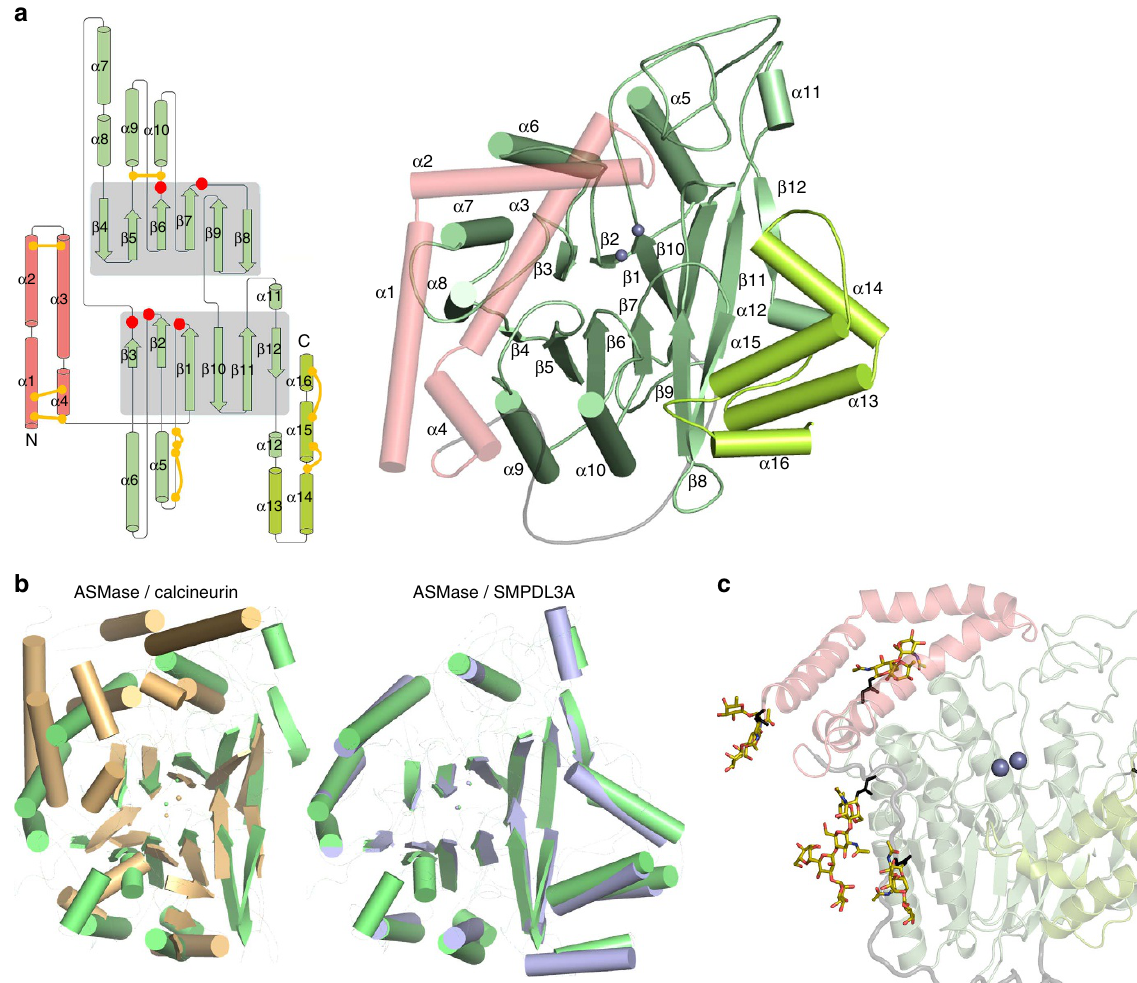
Figure 2 | The ASMase fold. ( a ) Left: topology diagram of ASMase. The central b -sheets of the catalytic domain are highlighted with grey shading. Strands are represented by arrows and a -helices by cylinders. The topology of the open form of the saposin domain (pink) is shown; in the closed form, a -helix 3 is divided into two helices. Disulfide bonds are represented by yellow connectors. Red circles indicate regions of metal binding or catalytic residues. CTD helices are coloured lime green. Right: structure of ASMase with secondary structure elements labelled. ( b ) Comparison of the ASMase structure with related phosphodiesterases. The b -sandwich fold of the ASMase catalytic domain (green) is comparable to that of related phosphodiesterases, including calcineurin (PDB code 3LL8, overall sequence identity ¼ 10%, root mean squared deviation (r.m.s.d.) ¼ 1.9Å for 40 corresponding a -carbons from the conserved b -strands only), displayed in gold. In addition, the catalytic and C-terminal domains of ASMase are conserved in SMPDL3A (PDB code 5FC1, overall sequence identity ¼ 29%, r.m.s.d. ¼ 0.9Å for 281 corresponding a -carbons), which is displayed in blue. ( c ) Glycosylation sites (coloured sticks) on ASMase produced from insect cells. Asn N-glycan attachment residues are shown as black